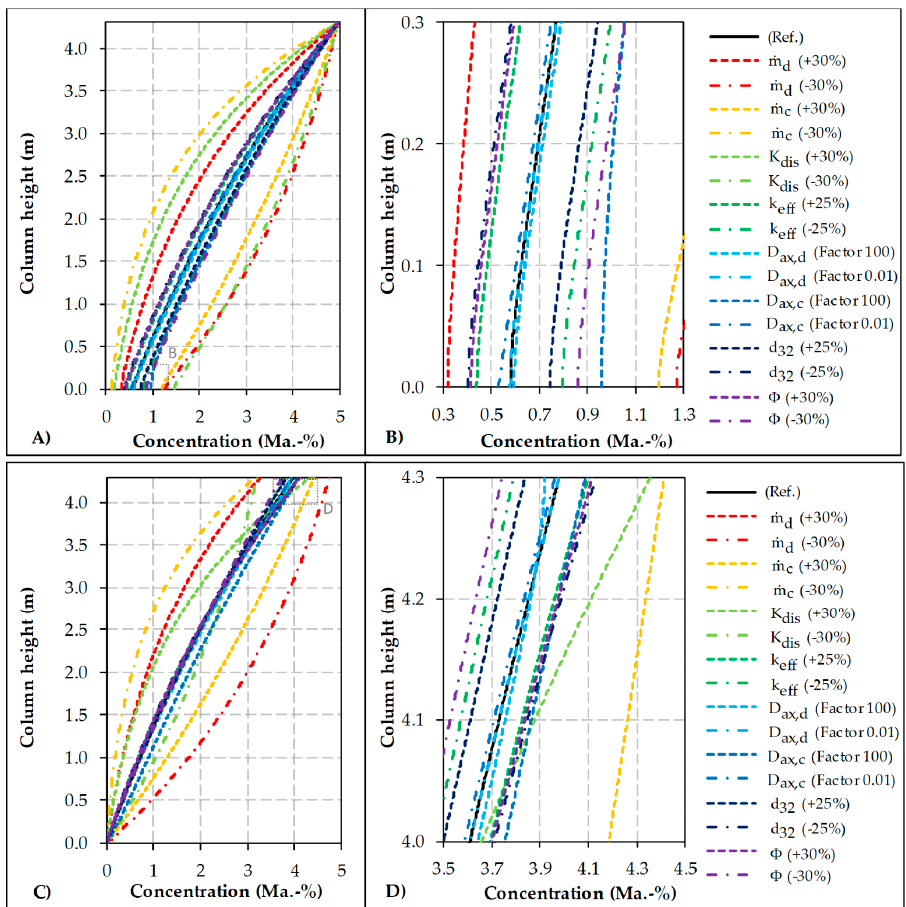
Figure 6. One-parameter-at-a-time sensitivity study. ( A , B ) Concentration profile of the continuous phase. ( C , D ) Concentration profile of the dispersed phase. The strongest impact on the concentration profile is achieved by altering the mass flow of the continuous, the dispersed phase and the distribution coefficient of acetone. ( B , D ) On the right hand side are insets of ( A , C ). The next step during sensitivity analysis is the performance of multi-parameter-at-a-time